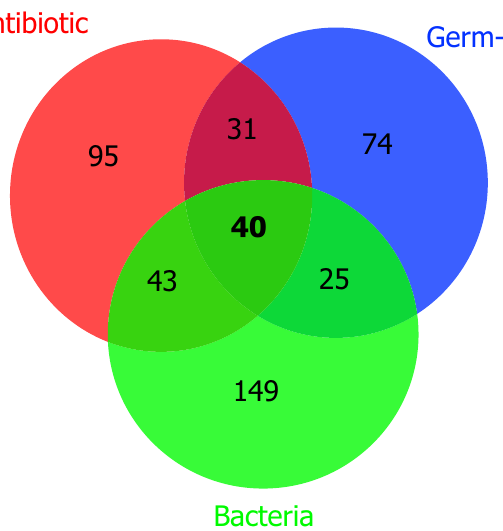
Figure 1. Venn diagram showing numbers of metabolites with microbial origin supported by one, two or three types of evidence. The three types of evidence are: produced by human faecal bacteria, reduced by antibiotic treatment, and reduced in germ-free animals.